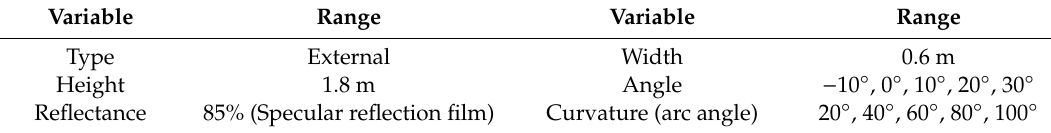
Figure 5. Illustration of the arc angle of a curved surface. Table 3. Performance evaluation variables for curved light shelves.